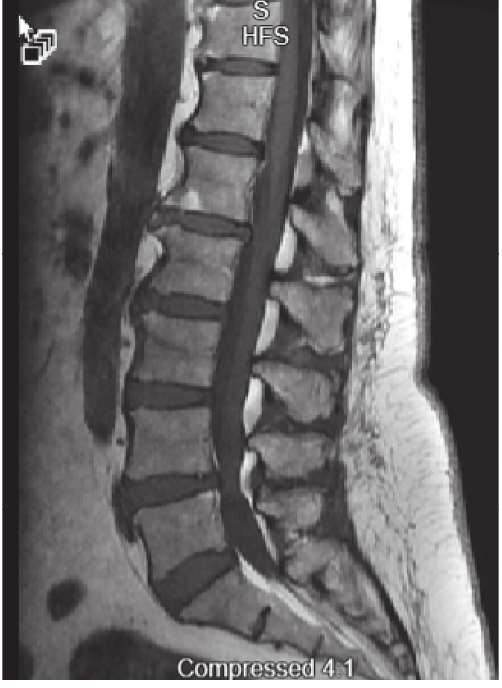
Figure 4: Lumbar MRI with contrast, demonstrating multilevel degenerative changes. There is facet arthropathy and ligamentum flavum hypertrophy. L4-5: there is a diffuse bulge slightly larger on the right. There is severe central canal stenosis. There is moderate right and mild-to-moderate left neural foraminal stenosis. L5-S1: there is a mild diffuse bulge slightly larger on the left with a tiny left foraminal annular tear. There is severe left and moderate right neural foraminal stenosis. L1-2: there is diffuse bulge and a superimposed central protrusion. There is mild-to-moderate central spinal canal